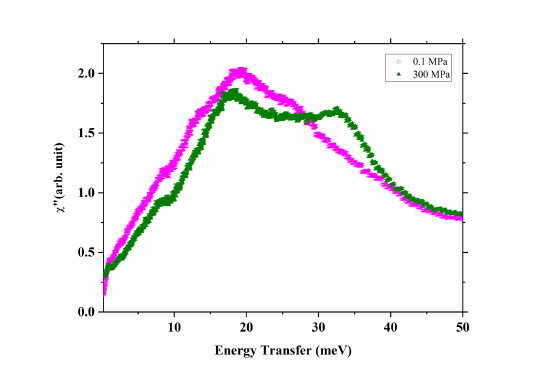
Fig. 8. The imaginary part of the dynamic susceptibility indicates the phase transition from the α -phase to β - phase upon applying 300 MPa pressure for NH